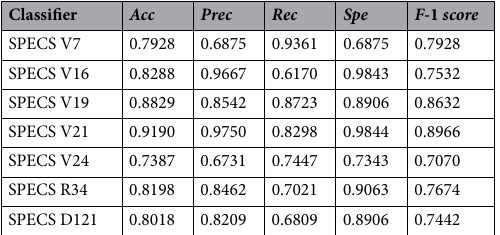
Table 6. Experimental results on evaluation metrics for test samples in dataset D 1 .